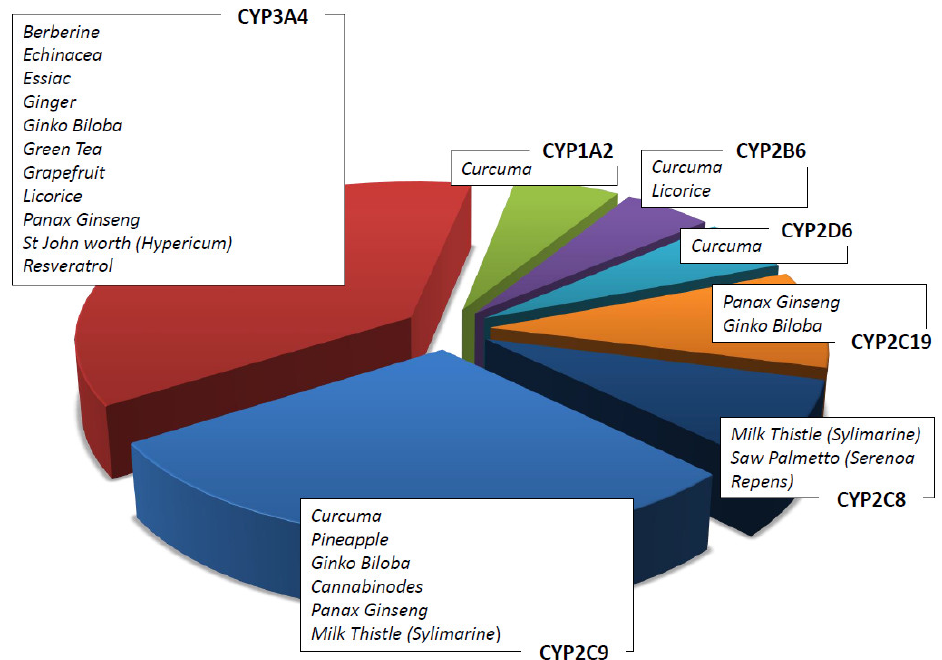
Figure 3. Herbs/nutraceuticals commonly used as CAMs that induce and/or inhibit different CYP subfamilies.